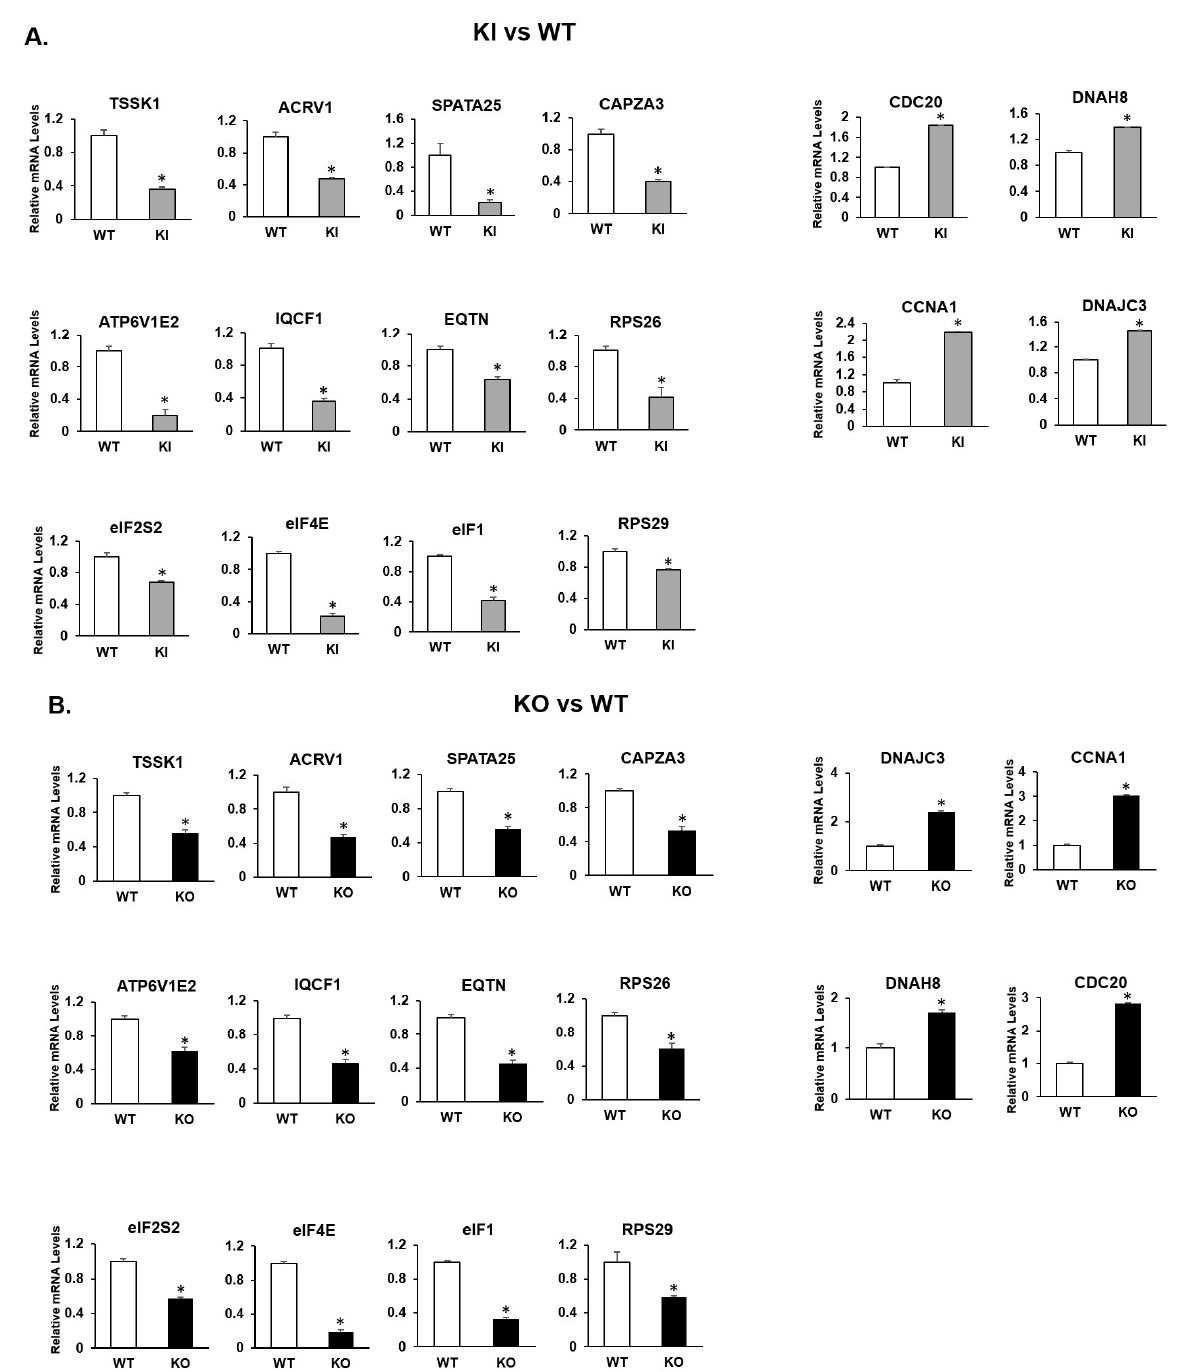
Figure 5. Expression of selected DEGs from RS clusters was measured by qRT-PCR. Bar graphs represent the fold change expression between KI vs. WT ( A ) and KO vs. WT ( B ) groups. Means ± SEM were determined from three independent qRT-PCR experiments with each sample run in triplicate. p values were calculated by two-tailed Student’s t -test (asterisks indicate p < 0.05).